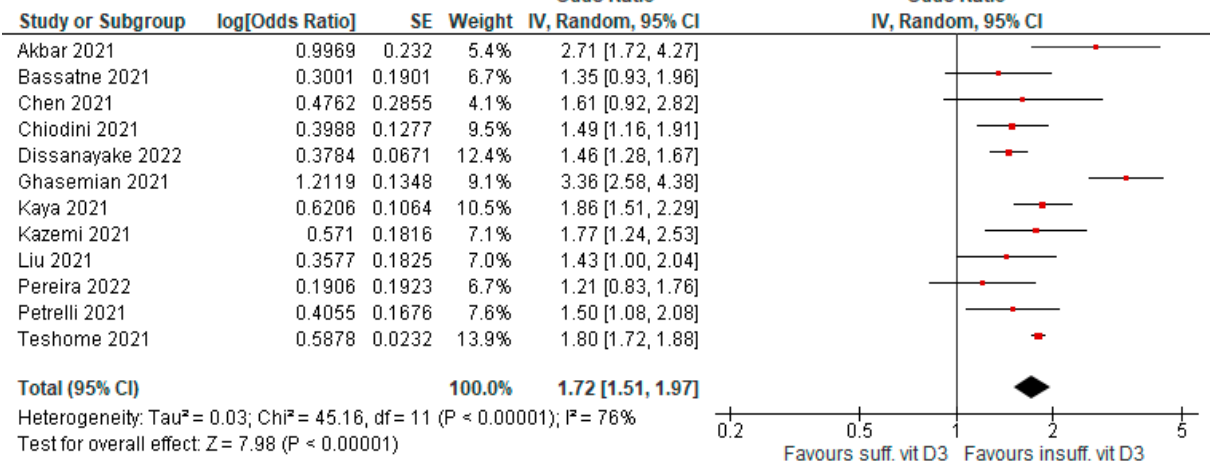
Figure 2. Forest plot showing results for the association of vitamin D3 levels and COVID-19 infection risk.